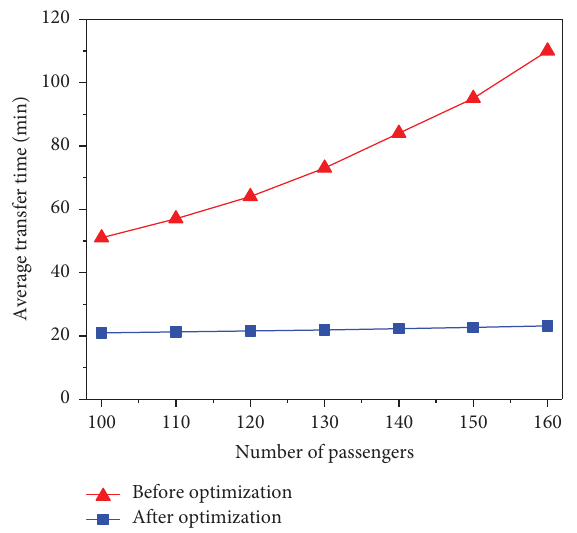
Figure 7: Infuence of the number of passengers on average transfer time.